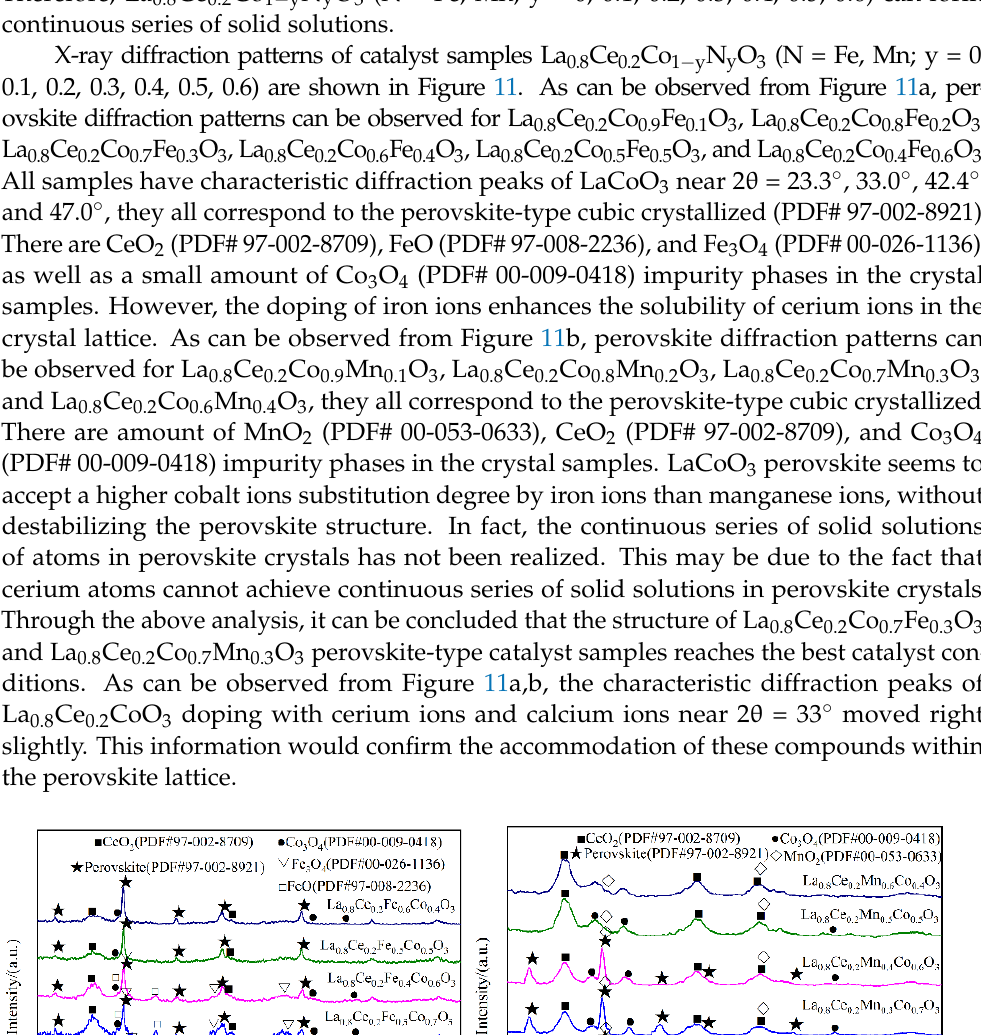
Figure 12. FTIR spectra of La 0.8 Ce 0.2 Fe 0.3 Co 0.7 O 3 and La 0.8 Ce 0.2 Mn 0.3 Co 0.7 O 3 catalyst samples. 3.4. Results of Simulation Experiments on Catalyst Samples Doping at B Site Figure 13a–d shows the fitting curves of the purification efficiencies of NO x , PM, HC, and CO over time when the B site was doped with different concentrations of iron ions. As can be observed from Figure 13, when the purification time does not exceed 90 s, the purification efficiency increases with time. When the time exceeds 90 s, the purification efficiency reaches the highest. When the purification time exceeds 180 s, the purification efficiency of NO x and PM shows an obvious downward trend. When y = 0.3, the purifica-